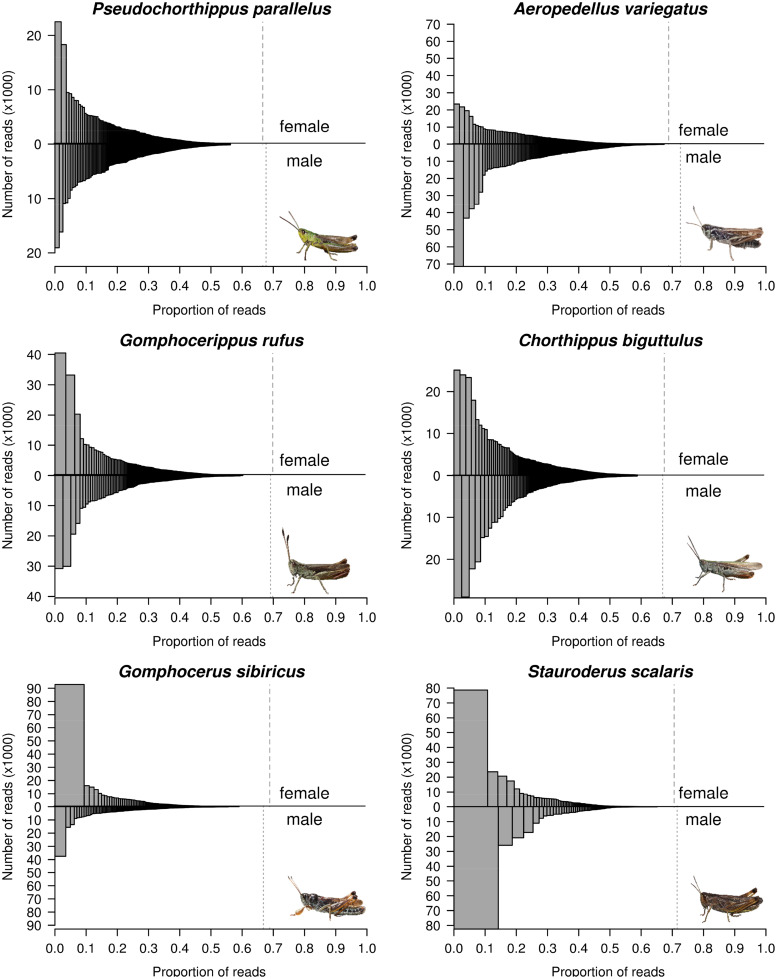
Distribution of de novo assembled repeat content over repeat clusters. The upper half of the plot shows results for the female sample whereas the lower half shows the male sample. Each histogram is based on a single clustering run, with other runs being qualitatively similar. Dashed vertical lines show the estimated repeat content for males and females as estimated by RepeatExplorer based on this single run.